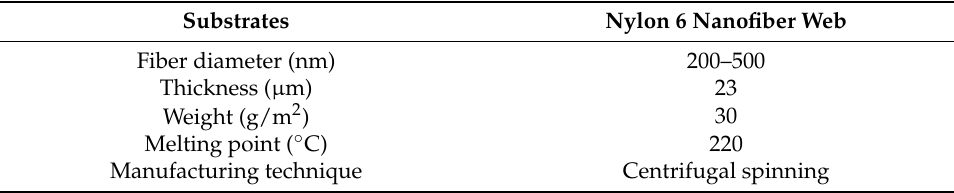
Table 1. Properties of the nylon 6 nanofiber web 1 .